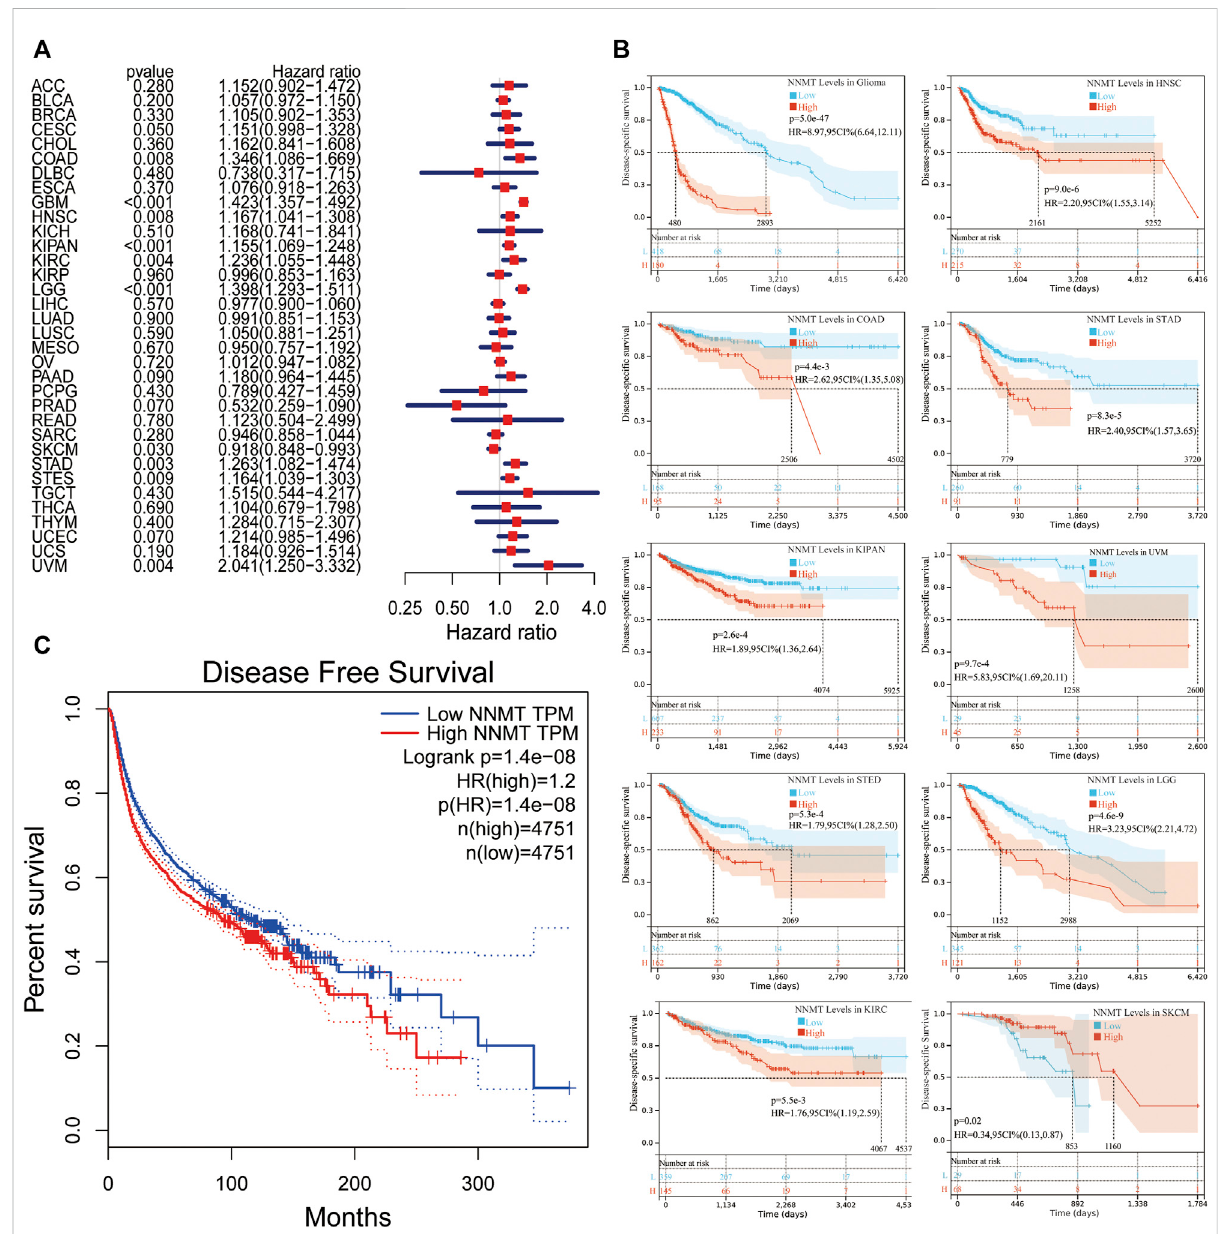
FIGURE 5 The correlation between disease-speci fi csurvival and NNMT expression in days (DSS). (A) Cox regression analysis of associations between DSS and 33 tumor types using a single variable. (B) A Kaplan-Meier analysis of the relationship between NNMT expression and DSS (C) The Kaplan-Meier median expression value analysis between NNMT transcription and disease-free survival (DFS) in 33 unique types of